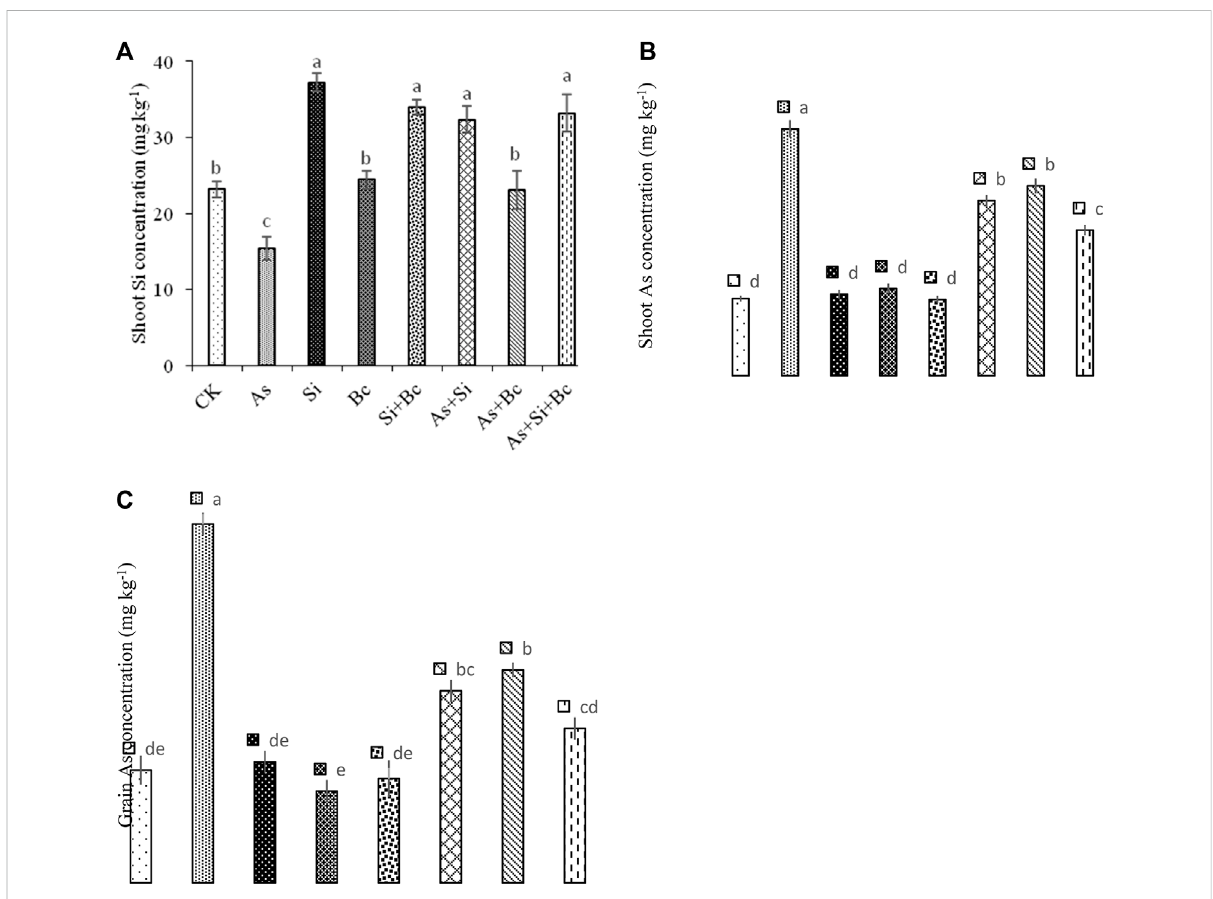
FIGURE 5 Effect of sole and combined application of silicon and biochar on shoot Si concentration (A) , shoot As concentration (B) , and grain As concentration (C) ofmaizeunderAstoxicity. Barssharingthesameletterdo nothaveasigni fi cant( p < 0.05)difference.Errorbarsshow thestandard error of